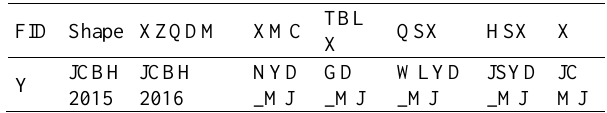
Table 1. The attribute table of illegal land use spots